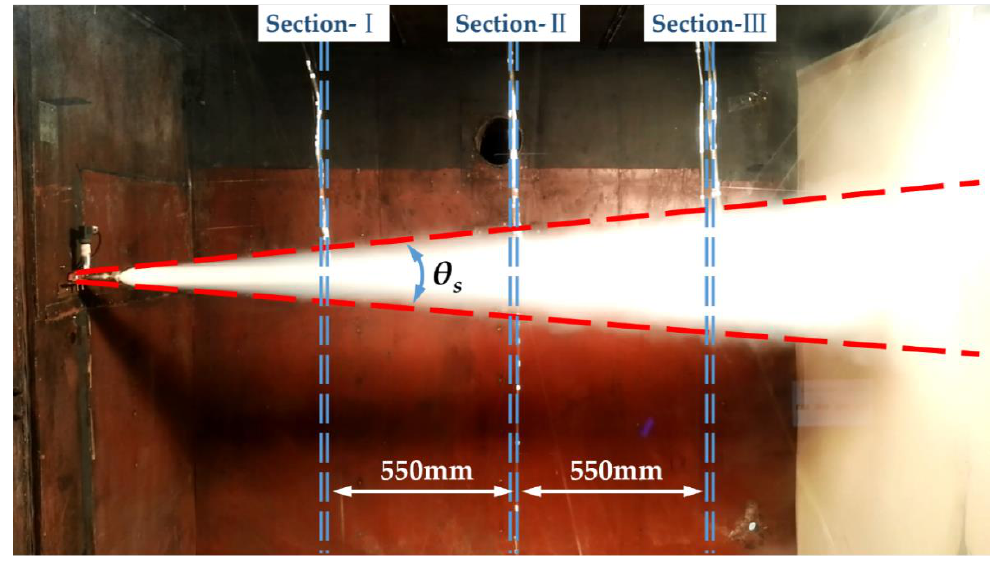
Figure 10. Jet Figure 10. Jet angle.